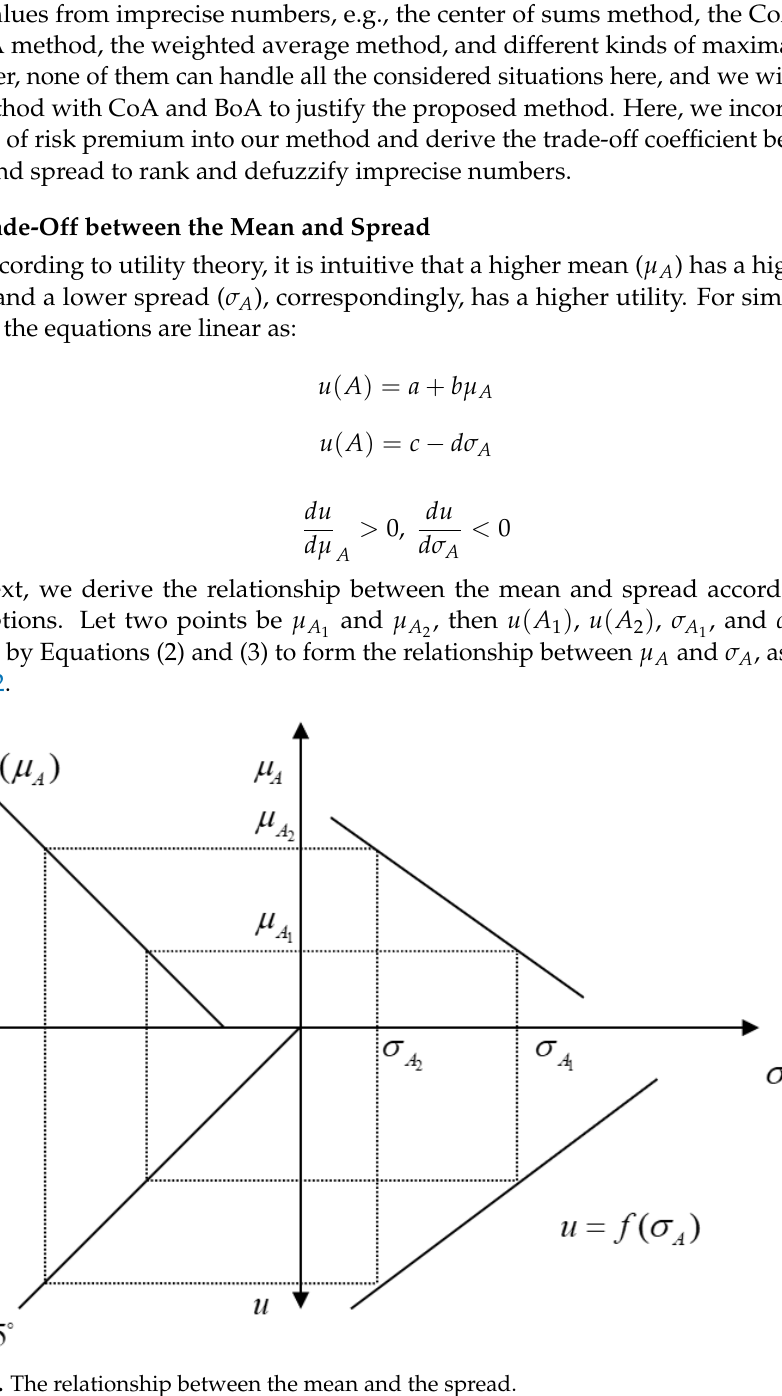
Figure 2. The relationship between the mean and the spread.